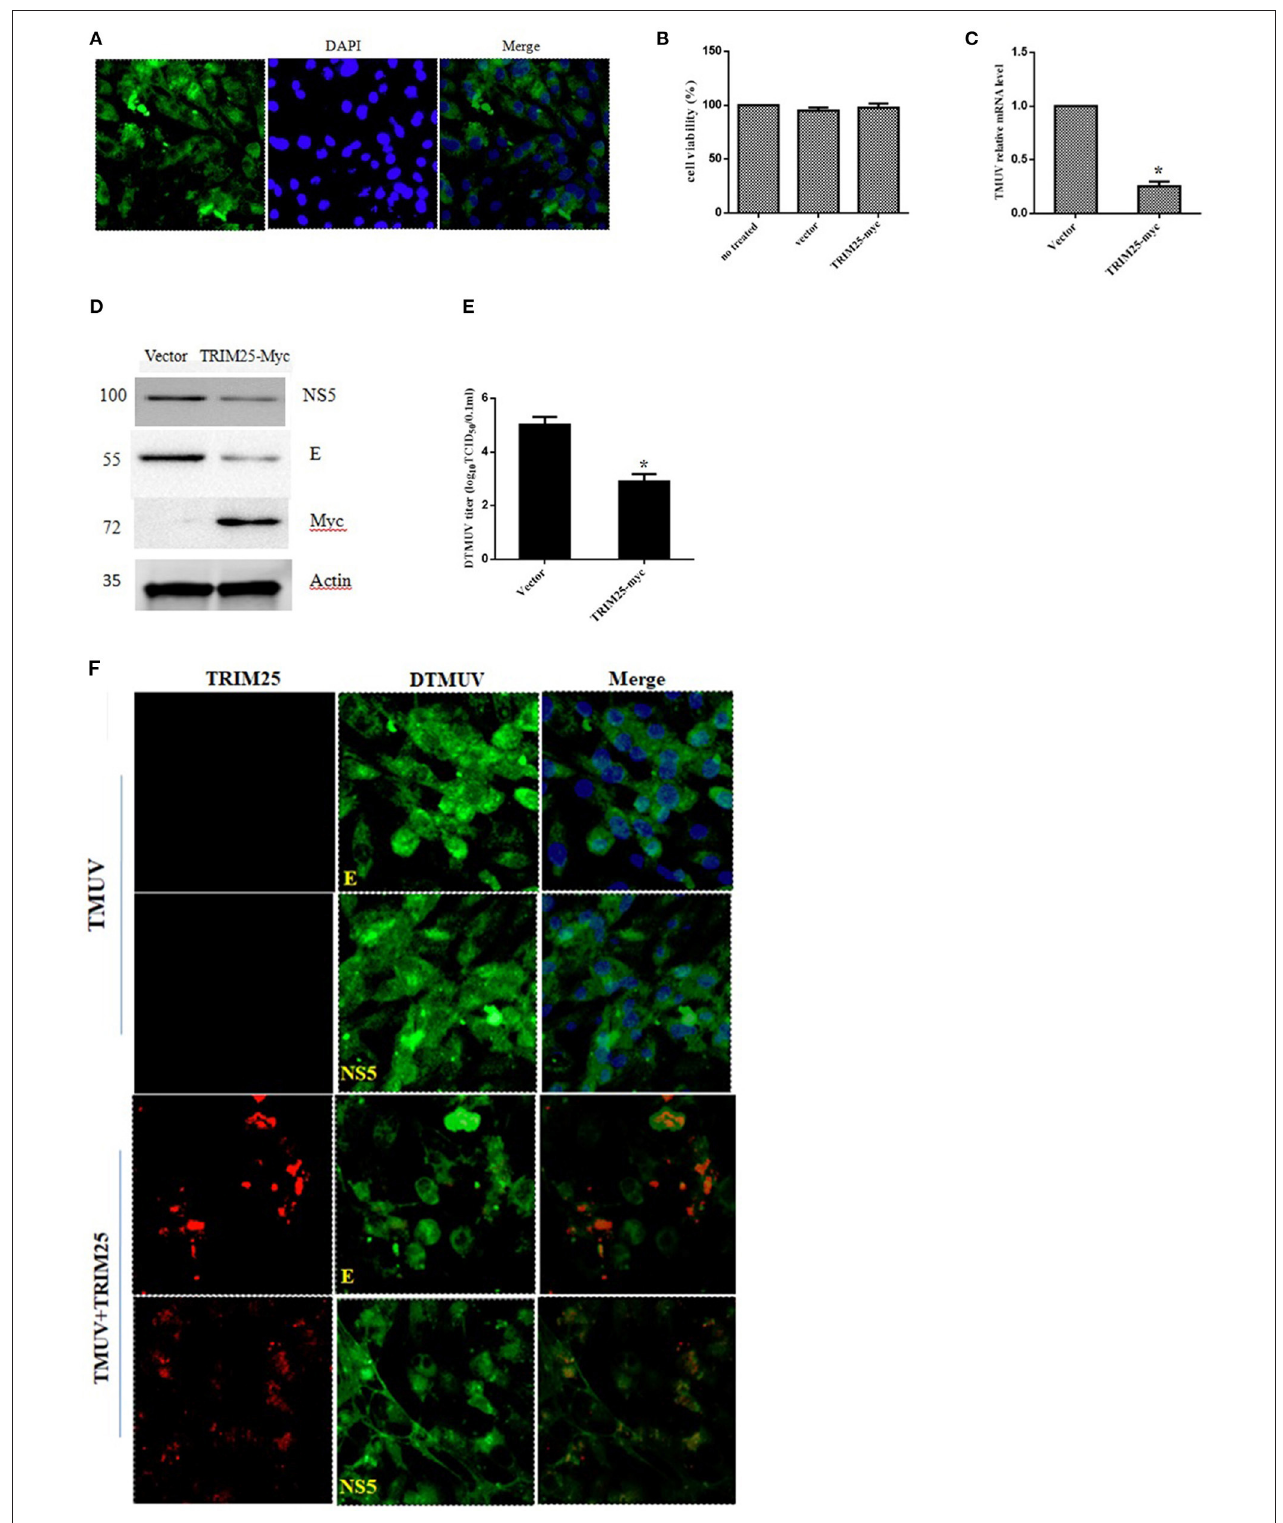
FIGURE 4 | The replication of duck Tembusu virus (DTMUV) is limited by TRIM25. (A) Expression of TRIM25 by immunofluorescence. Duck embryo fibroblasts (DEFs) were transiently transfected with the pcDNA3.1-c-myc-TRIM25 plasmid. Nuclei were stained with DAPI. (B) Cell viability assays after transfection with TRIM25